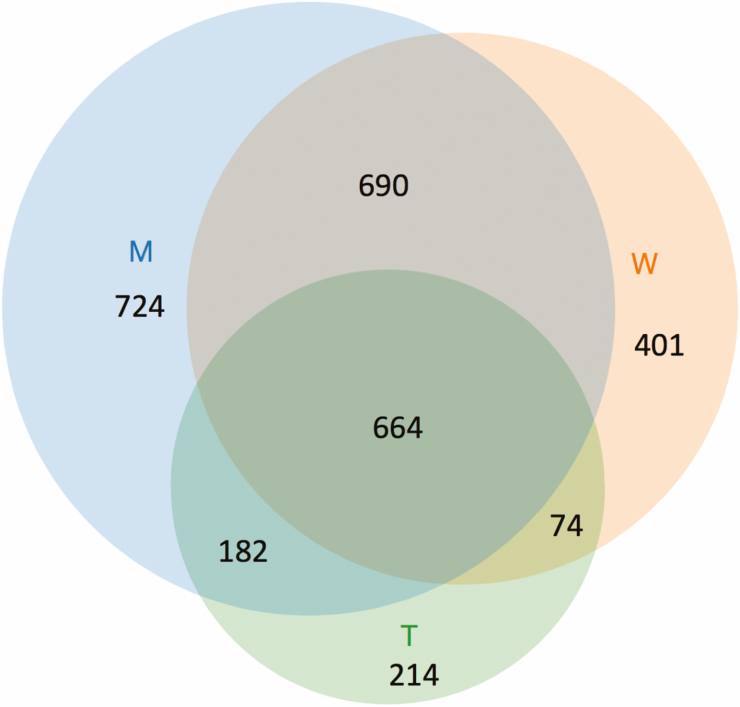
Venn diagram of identified proteins in S. invicta worker antenna (W), male antenna (M) and worker tibia (T).